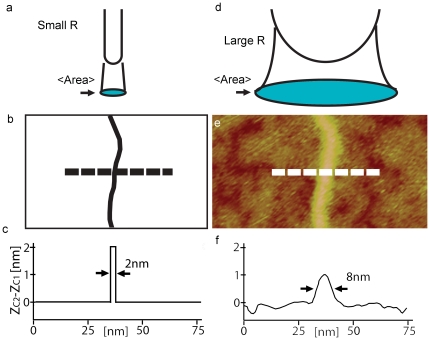
Scheme of a hypothetical point area versus experimental outcomes where the area is finite.(a) Scheme of the small <Area> (blue) with a hypothetical delta-function tip on a perfectly flat surface. (b) Hypothetical topographic scan of a dsDNA molecule with such a tip and surface. (c) Scheme of the perfect height profile (dashed line) achieved with this hypothetical set-up. (d) Scheme of the larger <Area> (blue) resulting from a common physical tip (e.g. 5<R<30 nm). (e) Topographic scan of a dsDNA molecule on mica with a standard tip in AM AFM in air. (f) Experimental height profile (dashed line). The apparent height is approximately 1 nm or half its true height and it appears lower and broader. Breaks in the layer of surface contamination allow the apparent height of the DNA to be measured relative to the mica surface. The surface layer with troughs and valleys accounts for approximately 0.2 nm. Experimental parameters: (e) A0 = 3 nm and Asp/A0 = 0.9 (normalized set-point).